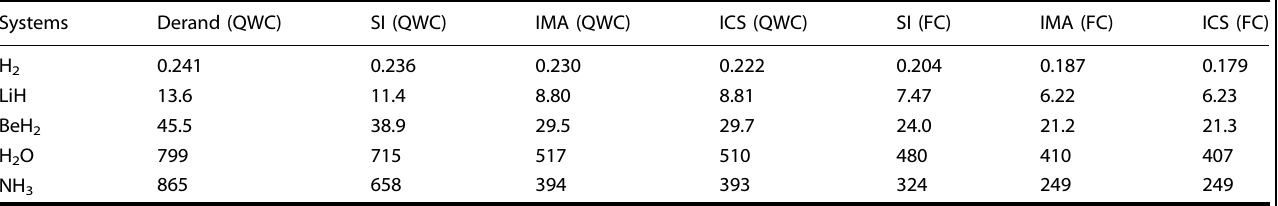
Table 6. Average number of measurements with random wavefunction and approximate covariances. Systems Derand